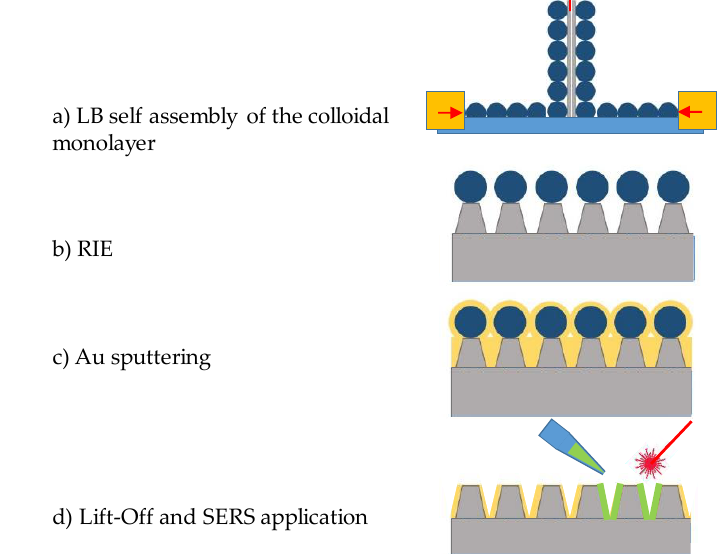
Figure 1. Schematic of the fabrication and final application of the Au crowned Si pillars. ( a ) Langmuir– Blodgett (LB) transfer of the colloidal monolayer, ( b ) reactive ion etching (RIE), ( c ) plasma sputtering of Au, and ( d ) lift-off and surface enhanced Raman spectroscopy (SERS) application.